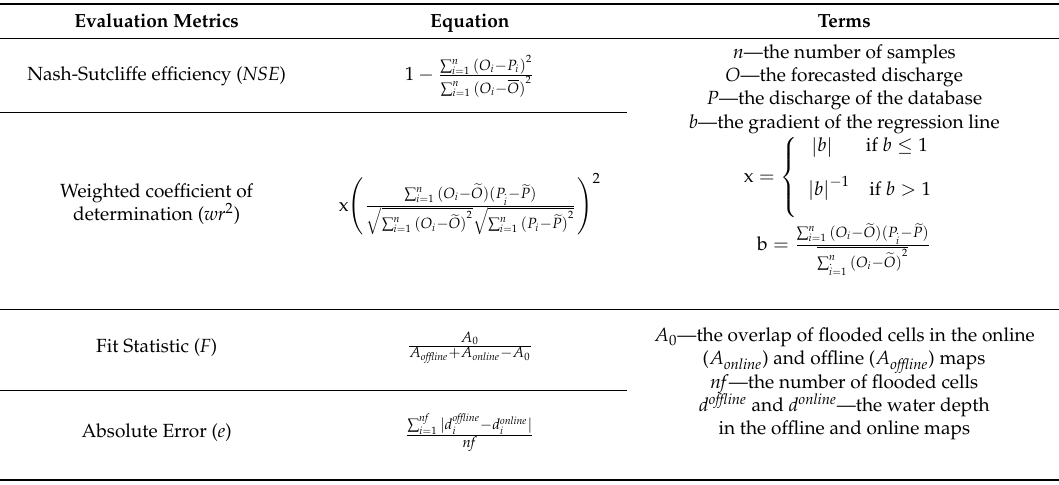
Table 1. Evaluation metrics used in the